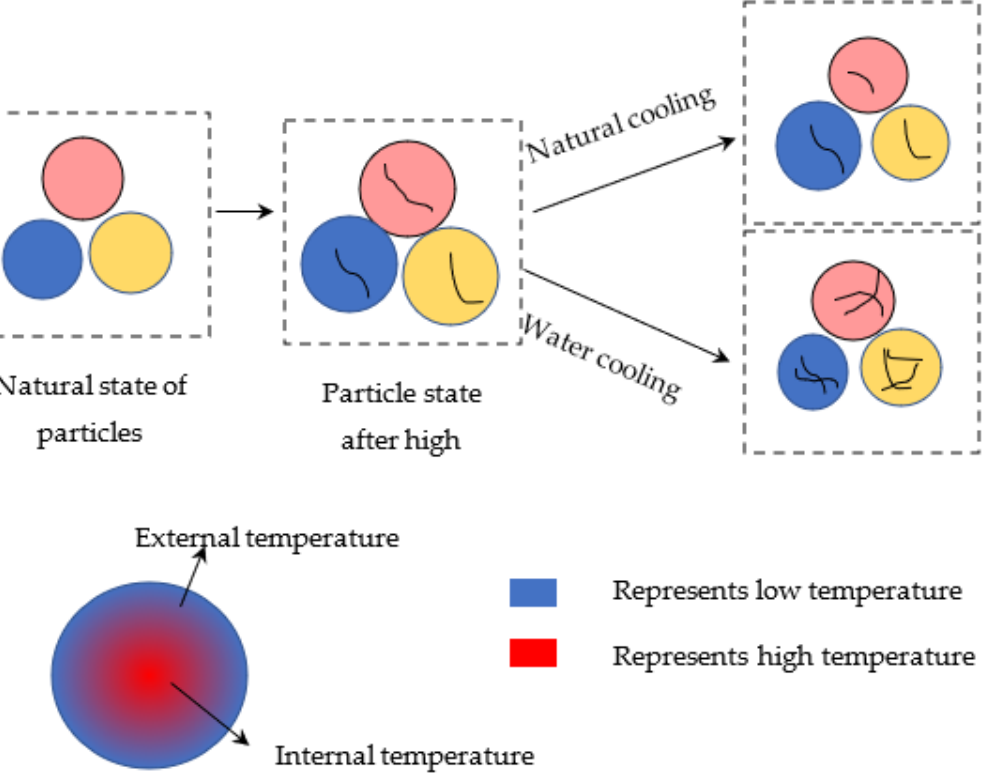
Figure 12. Damage process of granite sample under different cooling modes.